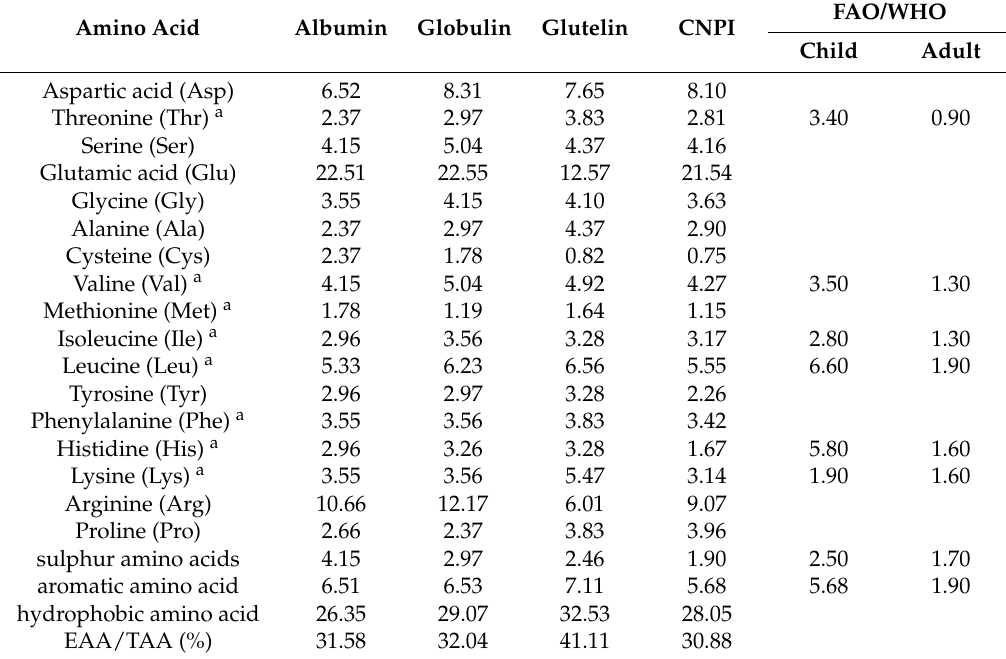
Table 2. Amino acid composition of cashew nut albumin, globulin and glutelin compare with CNPI from cashew nut (g/100 g